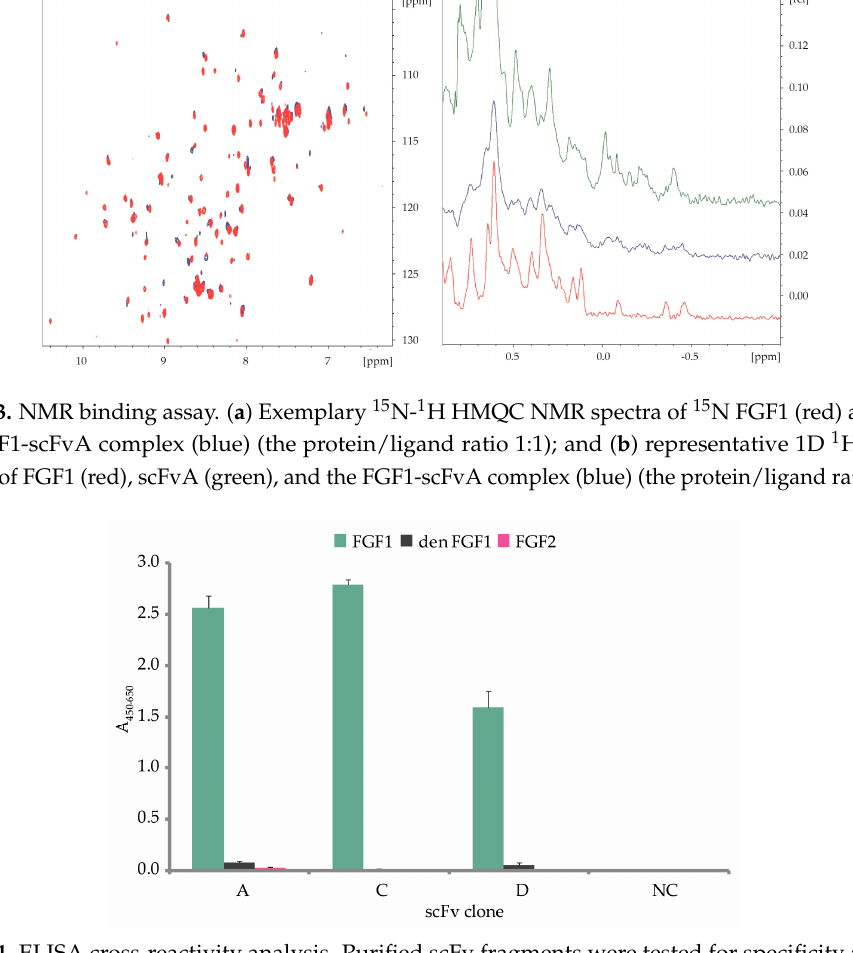
Figure 4. ELISA cross-reactivity analysis. Purified scFv fragments were tested for specificity against native FGF1 with thermally denatured FGF1 (den FGF1) and FGF2 serving as negative controls. A non-FGF1-specific scFv clone was used as an additional negative control (NC). The error bars show standard deviation.